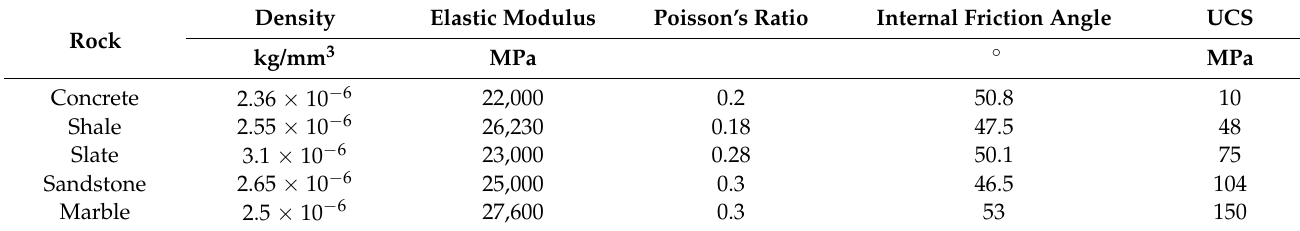
Table 2. Mechanical properties of rock.